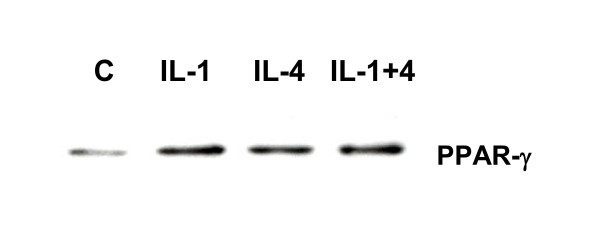
PPARγ is present in HGF nuclear extract. Fifteen μg nuclear extract isolated from untreated HGF and HGF treated for 24 hour with IL-1 (10 ng/ml), IL-4 (10 ng/ml), or IL-1 and IL-4 were separated on 10% SDS-PAGE, and transferred to nylon membrane. Proteins were detected with anti-PPAR-γ antibodies followed by chemiluminescence. C = control, no cytokines.